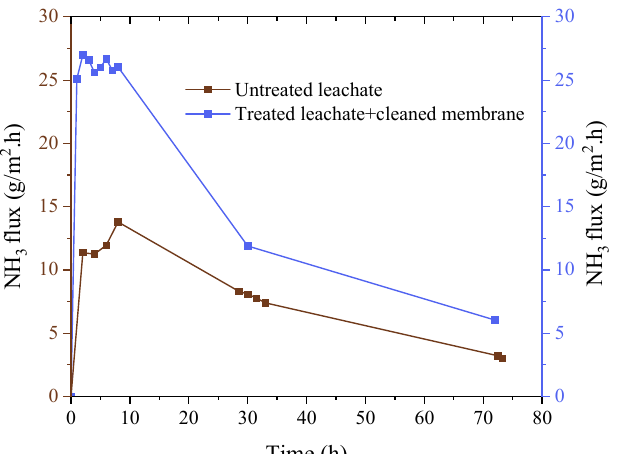
Figure 8. Ammonia flux of untreated leachate vs. treated leachate using a cleaned membrane with UV + H 2 O 2 .